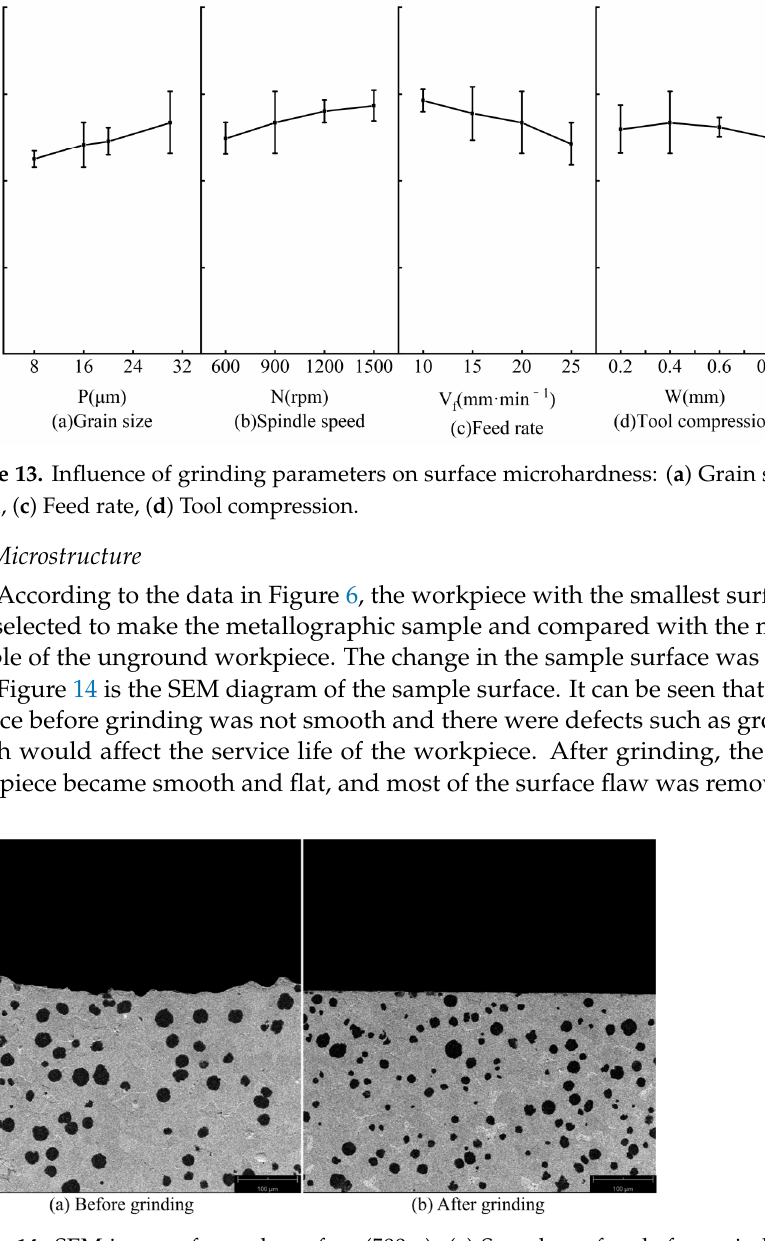
surface after grinding.